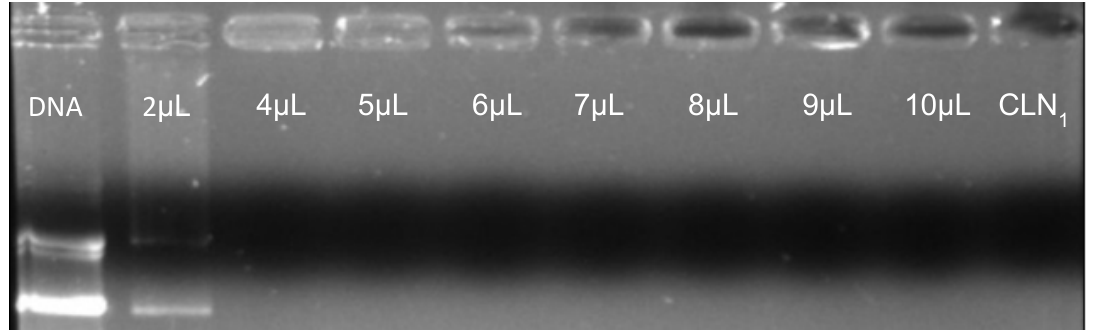
amount on the compaction of pDNA. 1